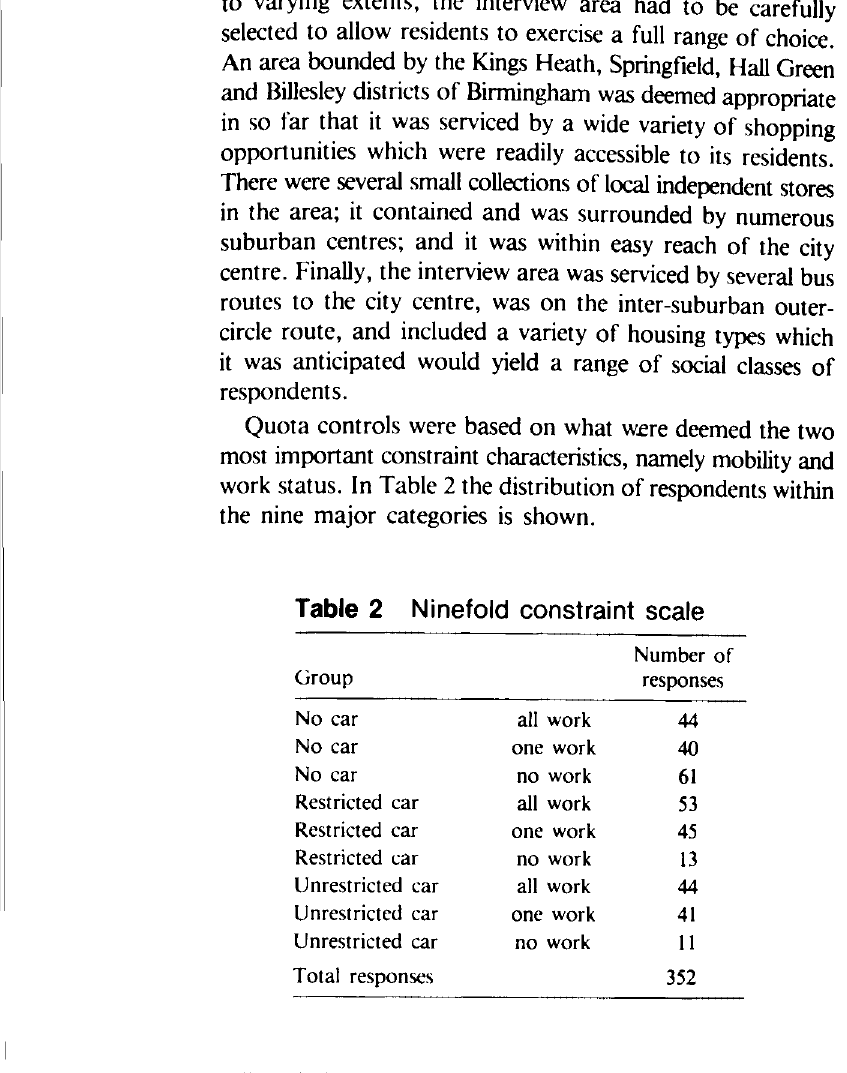
Ninefold constraint scale